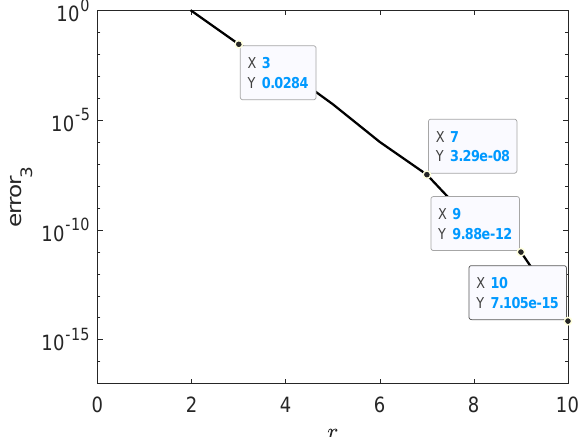
Figure 15. Errors for the Lorenz